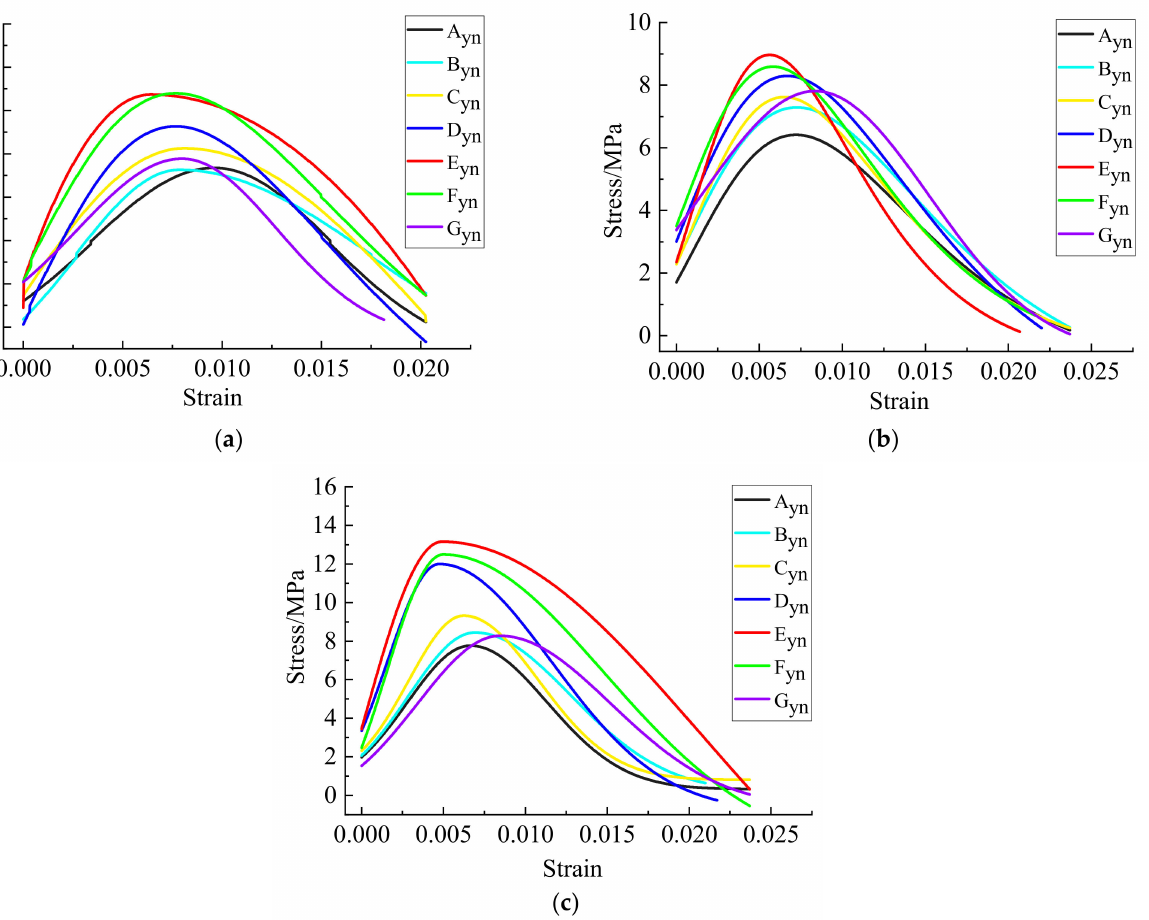
Figure 1. Relationship Curves of Dynamic Stress and Strain in Ni-Fe Slag Powder Soil Cement. ( a ) 7 d; ( b ) 28 d; ( c ) 60